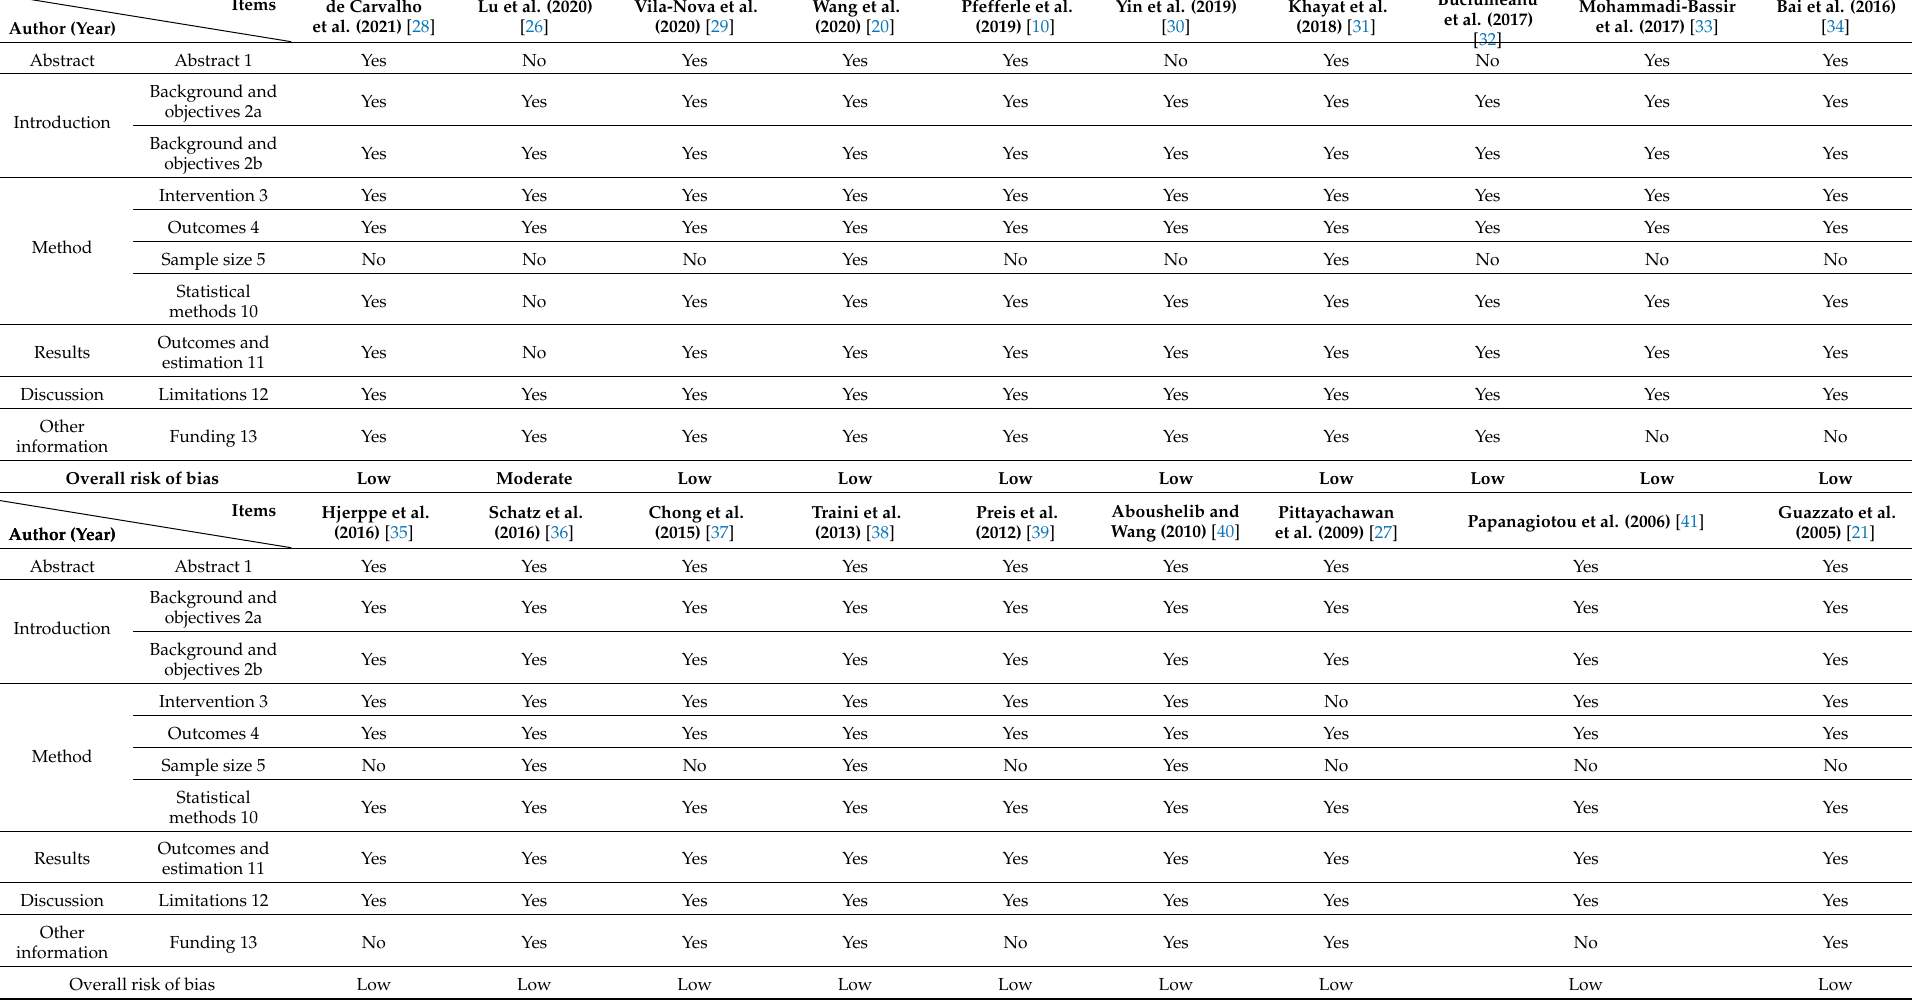
Table 2. Assessment of risk of